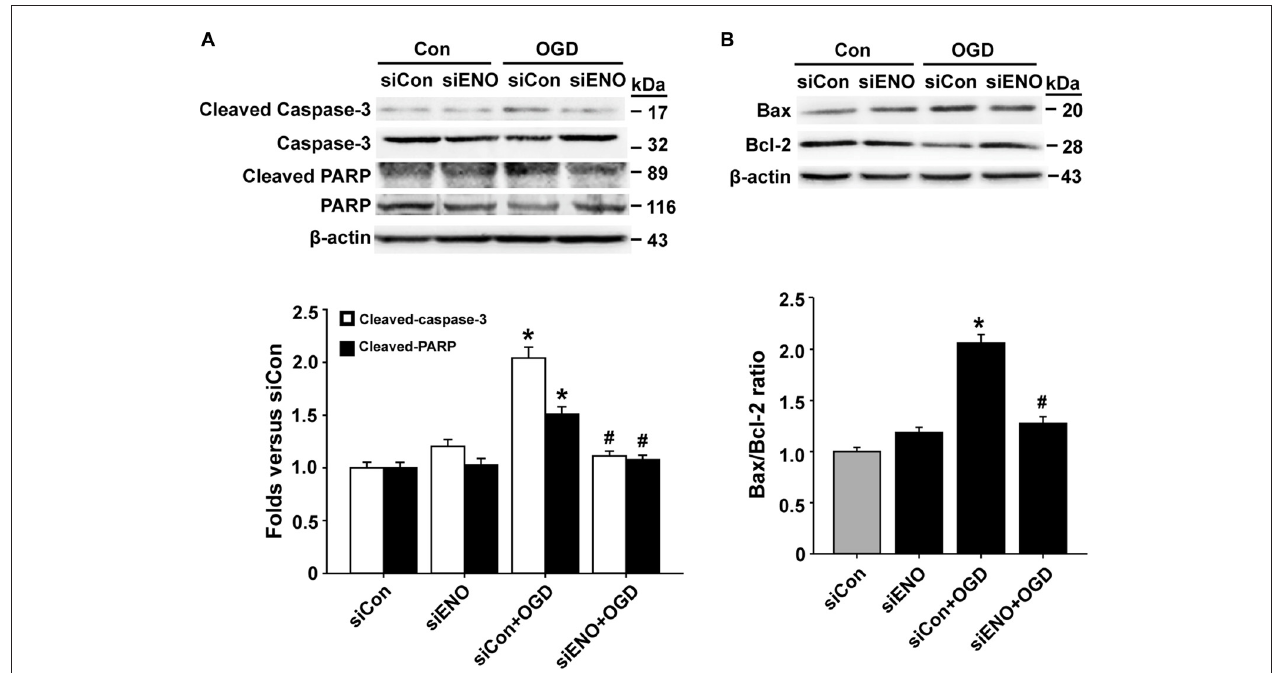
FIGURE 4 | Knockdown of ENOPH1 attenuates OGD-induced apoptosis-related protein expression in bEND3 cells. bEND3 cells transfected with siENOPH1 (siENO) or control siRNA (siCon) before exposing to OGD for 6 h. Apoptosis-related proteins were analyzed by western blot. (A) Upper panel: representative immunoblots showing the changes of cleaved and full length caspase-3 and PARP protein bands in bEND3 cells. β -actin was used as a loading control; bottom panel: quantitative data showed that OGD significantly increased the cleavage of caspase-3 and PARP and knockdown of ENOPH1 inhibited this change. ∗ P < 0.05 vs. siCon; # P < 0.05 vs. siCon + OGD; n = 4. (B) Upper panel: representative immunoblots of Bax and Bcl-2 proteins; bottom panel: quantitative data showed that OGD significantly increased the ratio of Bax/Bcl-2 and knockdown of ENOPH1 inhibited this increase. ∗ P < 0.05 vs. siCon; # P < 0.05 vs. siCon + OGD; n =